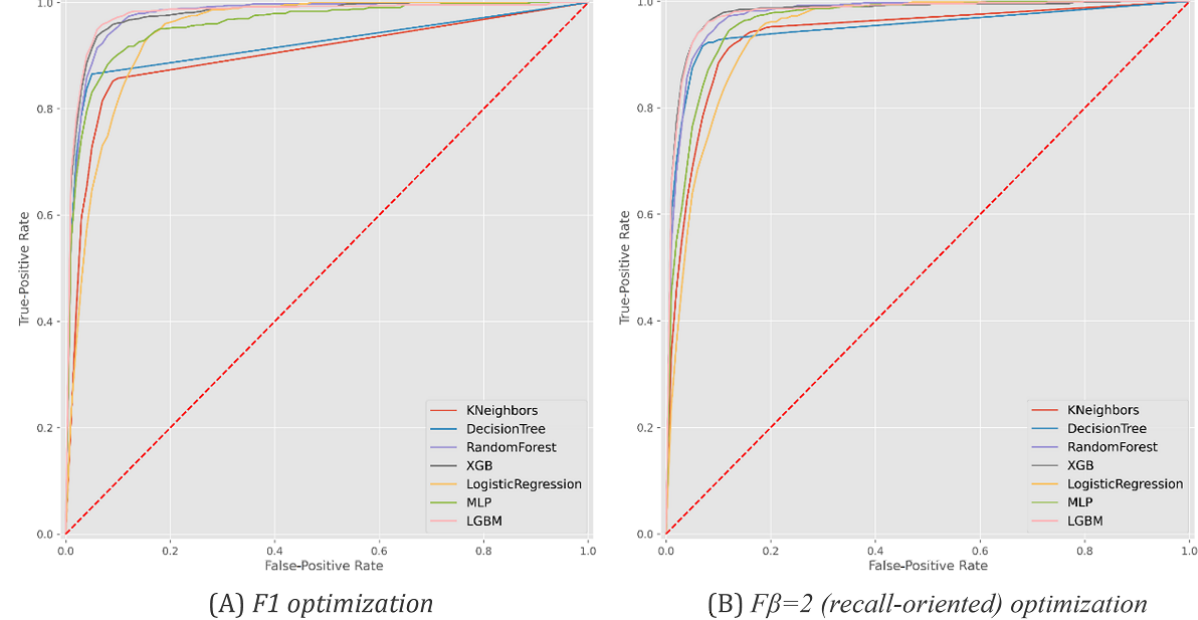
Figure 10. Receiver operating characteristic curves with the predictive behavior of the selected classifiers in asserting patient survivability at the time of hospitalization. XGB: XGBoost, MLP: multilayer perceptron, LGBM: